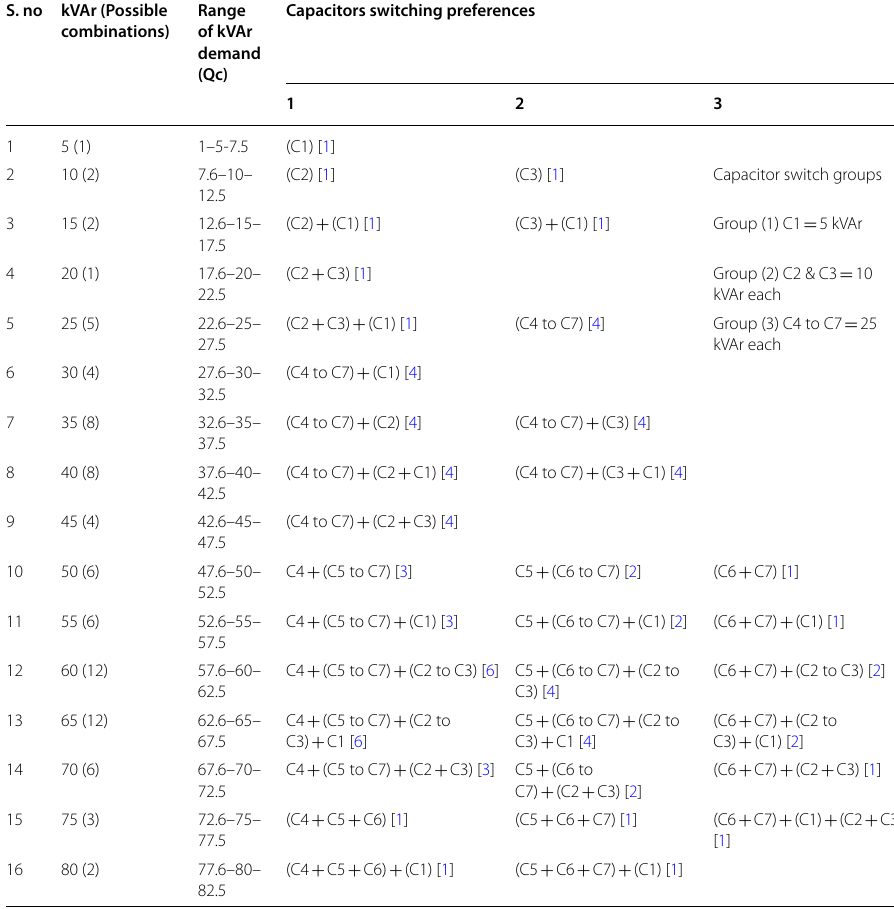
Table 6 Capacitor switching selection of 125 kVAr capacitor bank S. no kVAr (Possible